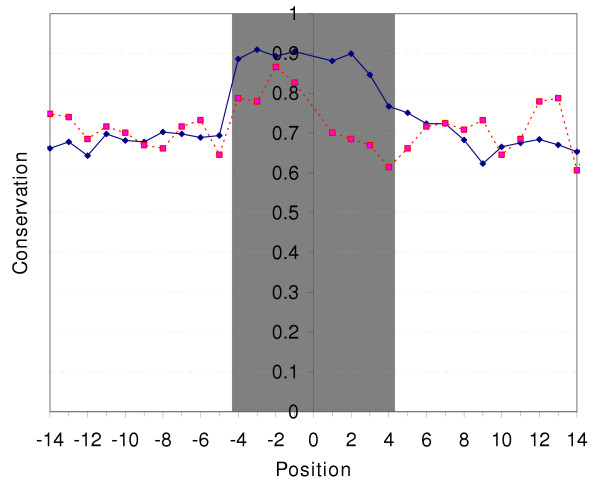
Average per-nucleotide conservation of TATA box and of 10 nucleotides to its left and right. Conservation of all four non-cerevisiae species is pooled together. Grey shading, TATA box; blue solid line, genes sensitive to mutations in DNA binding surface of TBP (N = 213); red dashed line, genes insensitive to mutations in DNA binding surface of TBP (N = 34).